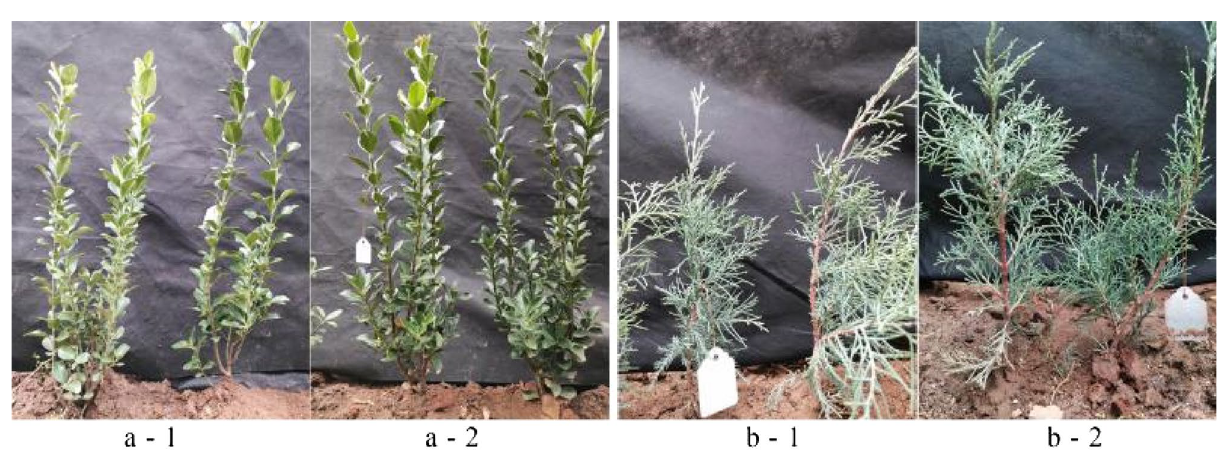
Figure 13. The leaf color and statement of Japanese Spindle ( Euonymus japonicus ) ( a ) and Juniperus sabina ‘Tamaricifolia’ ( b ) after 30 days of observation. Those with white hangtags were plant treated with polymer, while those without were